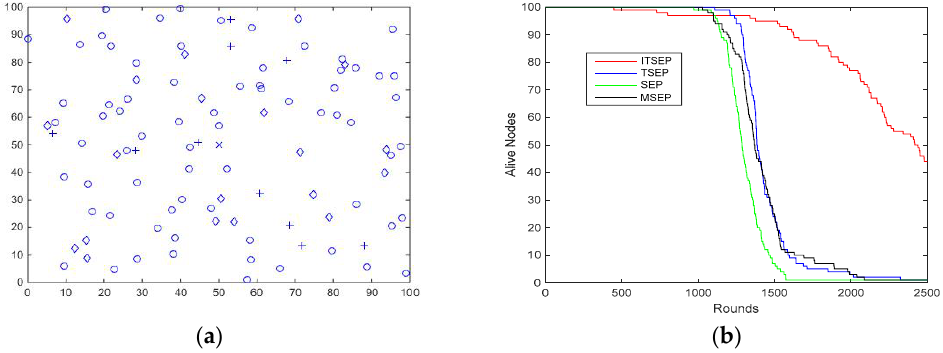
Figure 2. ( a ) Network model; ( b ) The number of alive nodes. ITSEP: Improved Threshold-Sensitive Stable Election protocol; TSEP: Threshold-Sensitive Stable Election Protocol; SEP: Stable Election Protocol; MSEP: Modified Stable Election Protocol.